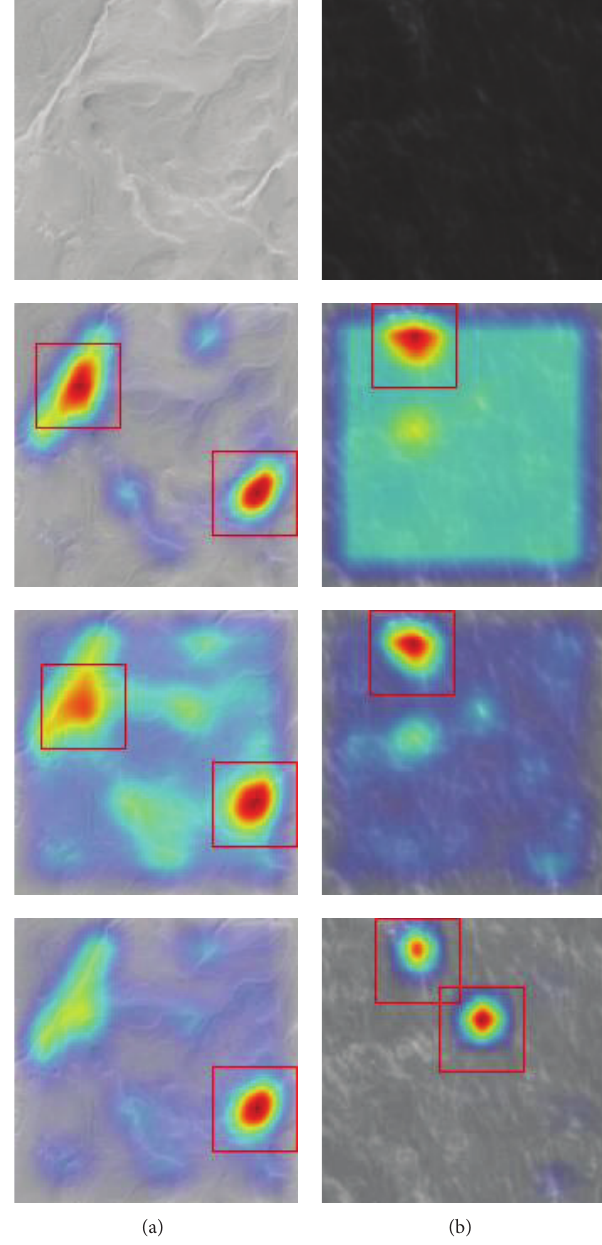
Figure 7: Results of waypoints in Class 1 (the first line is two reference images; the second line is the results of Li et al. [9]; the third line is Han et al.’s [12]; the fourth line is ours).